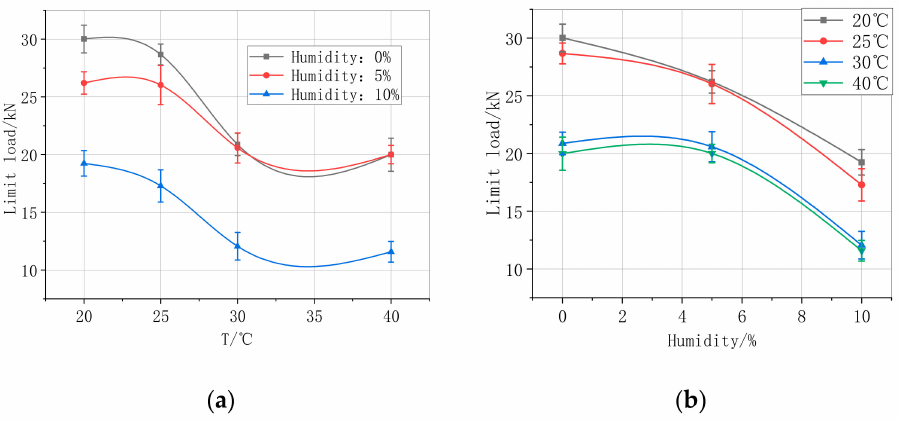
Figure 8. Limit load of CFRP parameters. ( a ) Temperature–load relationship under di ff erent humidity, ( b ) humidity–load relationship under di ff erent temperature.